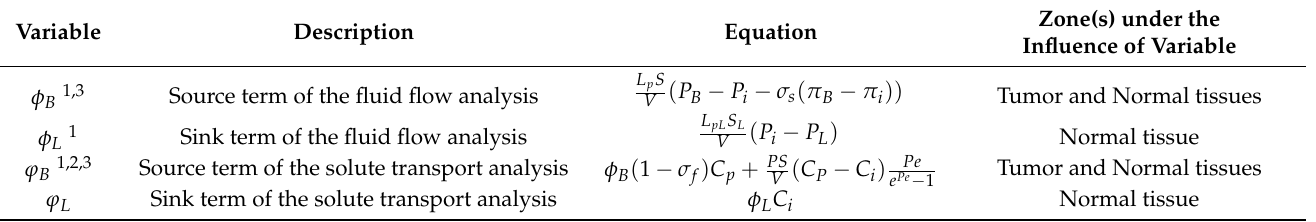
Table 1. Variables of Equations (1) and